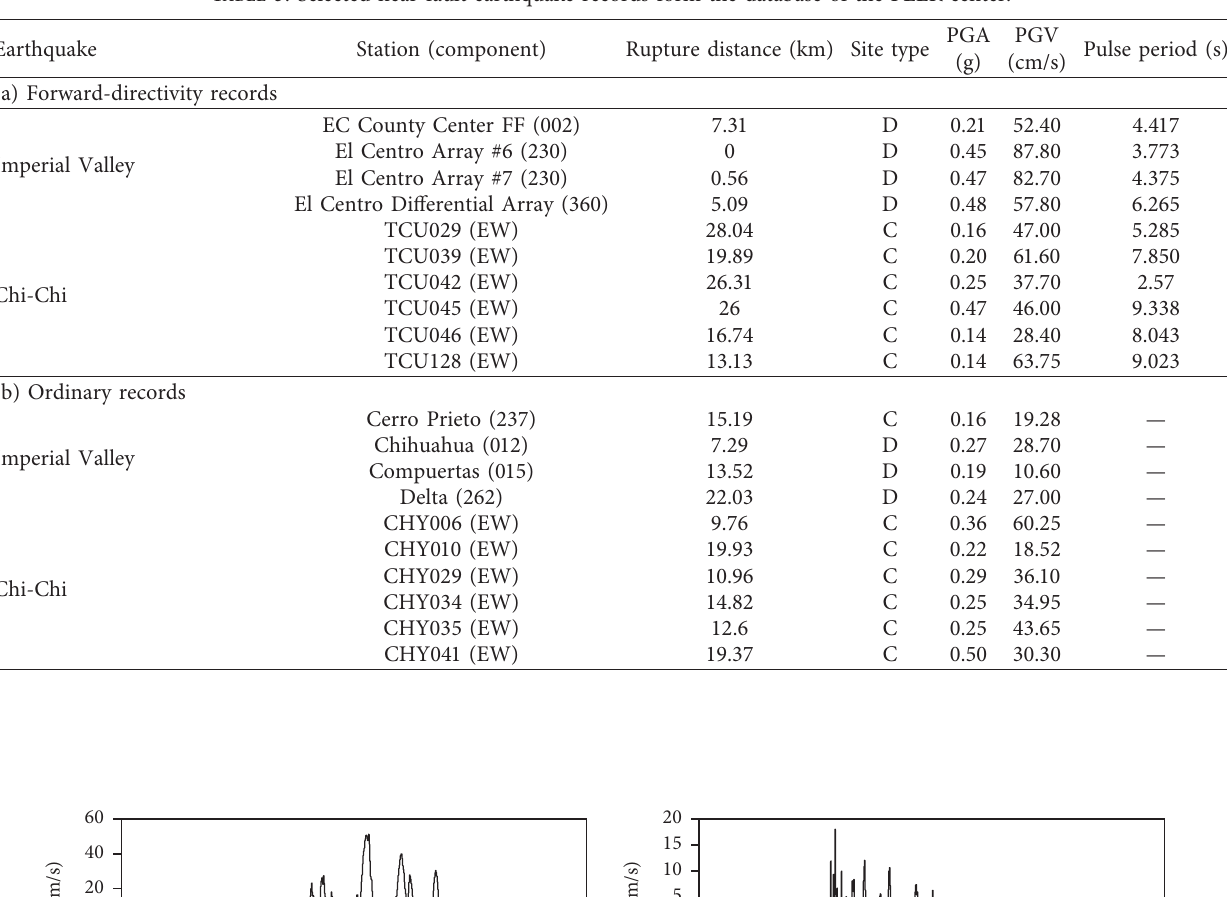
Table 5: Selected near-fault earthquake records form the database of the PEER center.